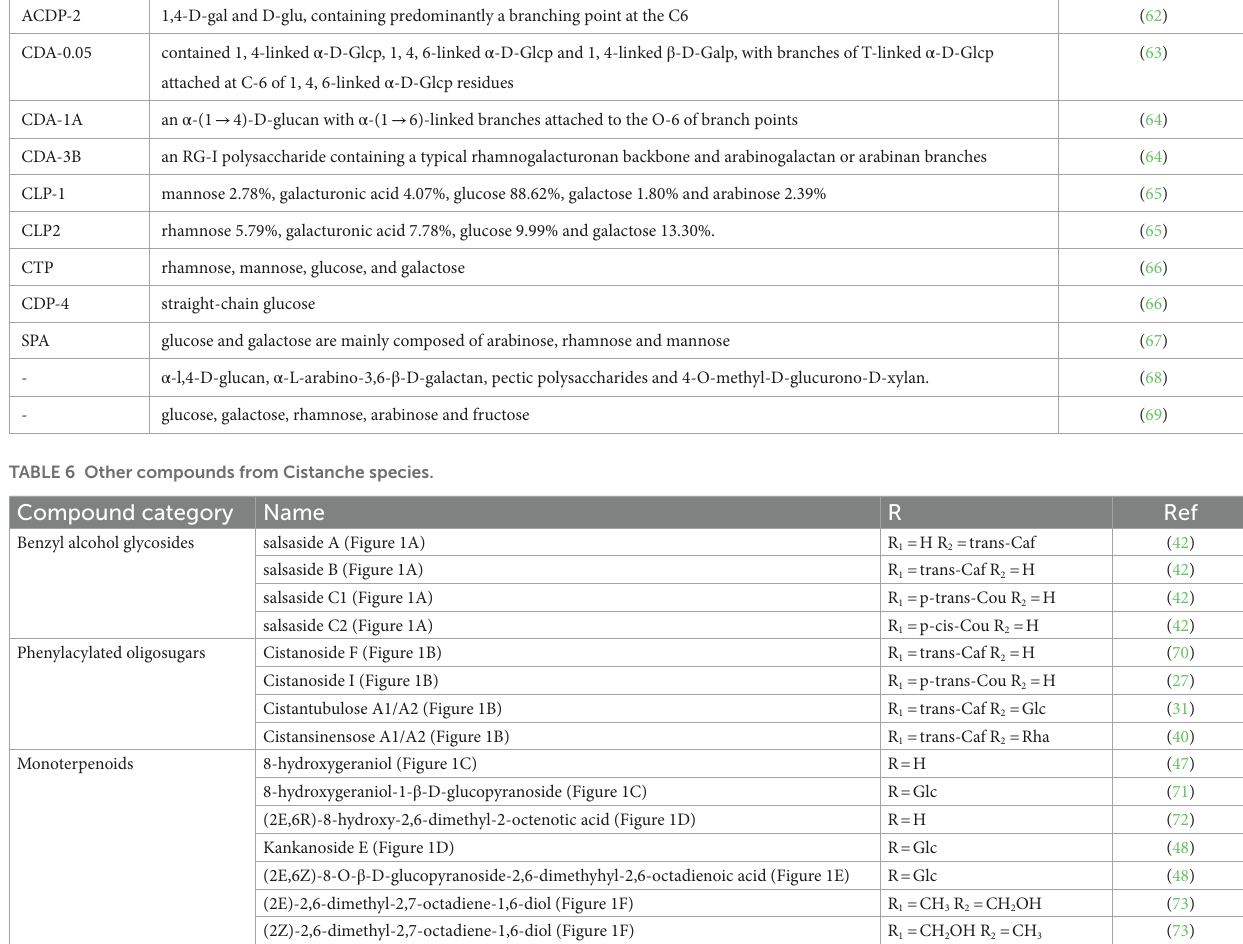
TABLE 5 Polysaccharides from Cistanche species.